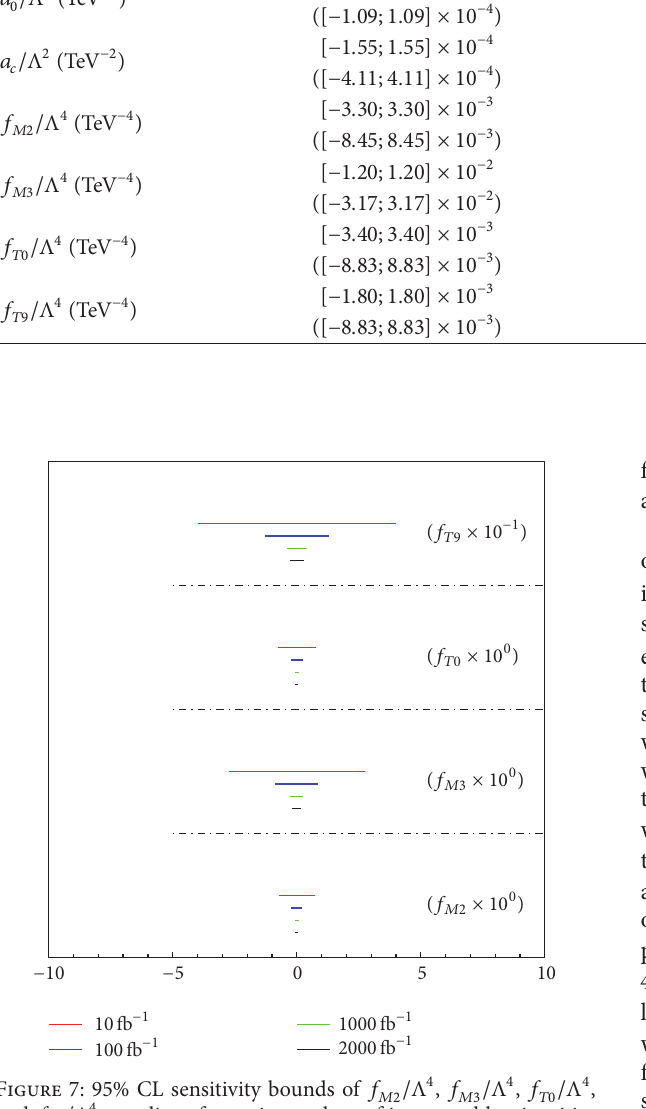
LHC, the sensitivities on the anomalous couplings are calcu- lated as [−1.1; 1.1] TeV −2 and [−4.8; 4.8] TeV −2 ,